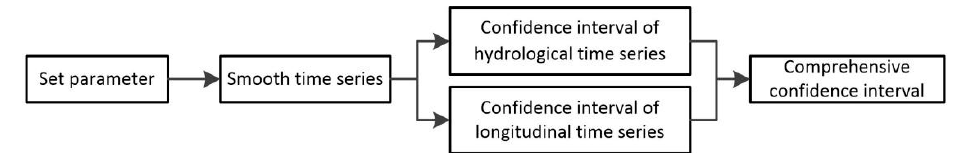
Figure 6. The flow chart of the statistical data quality control method.